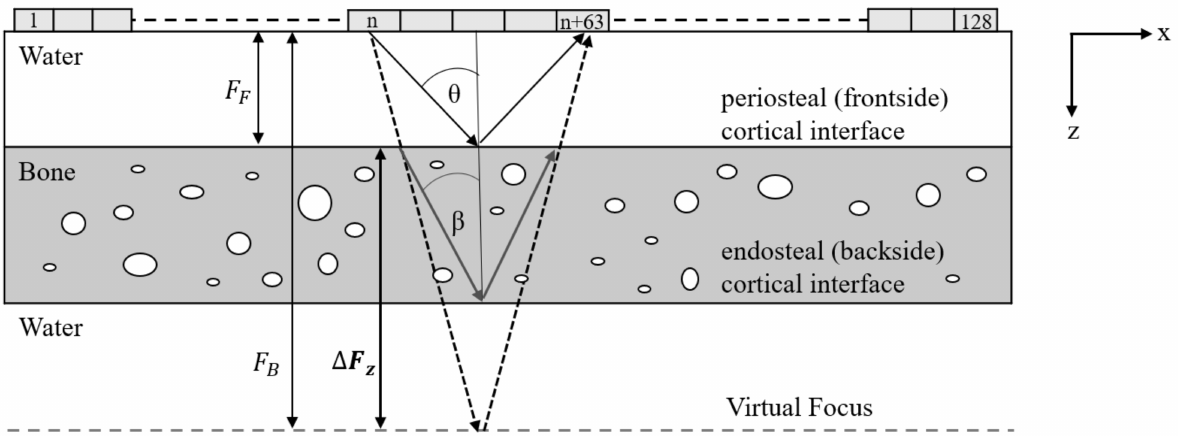
Figure 1. Schematic representation of the multi-focus measurement in the radial direction ( x , z ) of a long bone. The transducer is placed 15 mm above the sample. Focused sound beams are emitted using a 64-element sub-aperture of a 128-element linear array. The focus is shifted from a depth above the periosteal cortical interface to a depth below the endosteal cortical interface by gradually decreasing the semi-aperture angle θ of the transmit beam. Refraction at the periosteal interface changes the direction of the transmitted waves and results in a shift of the focus depth inside the bone. ∆ Fz is the focus depth shift required to focus from the periosteal (frontside F F ) to the endosteal (backside F B ) interface. In addition to scanning the focus depth, sub-aperture is scanned in the x -direction along the transducer array (adapted from [19] under the Creative Commons Attribution 4.0